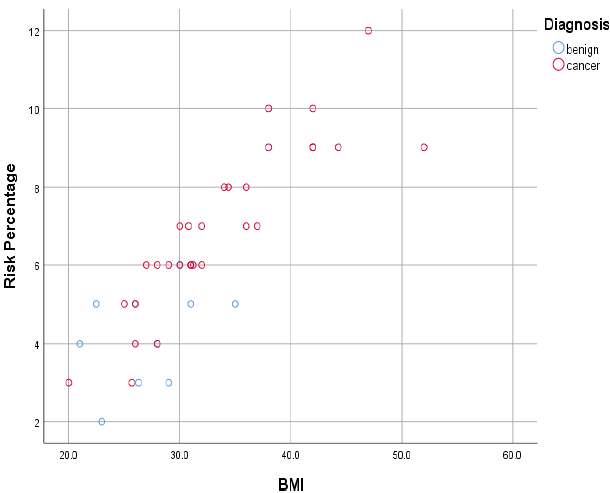
Figure 13. BMI–risk percentage scatter